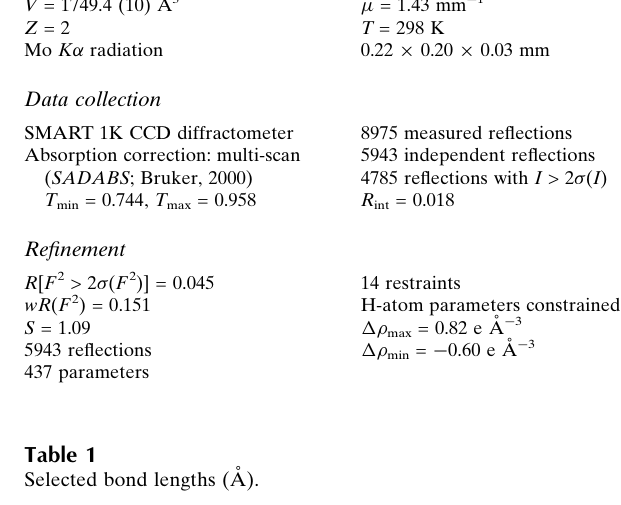
Selected bond lengths (A˚ ).